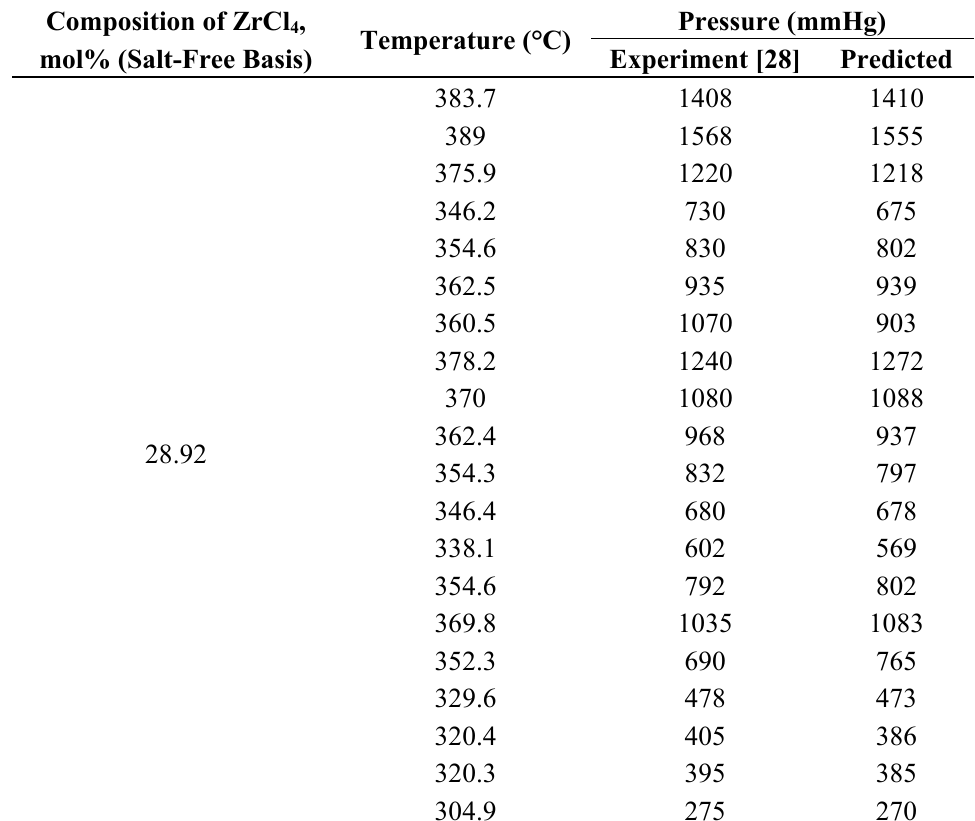
Table 1. Experimental and predicted total pressure for the different ZrCl 4 composition in the molten salt system (34.0 mol% NaCl and KCl (8:29 M); 66.0 mol% ZrCl 4 and HfCl 4